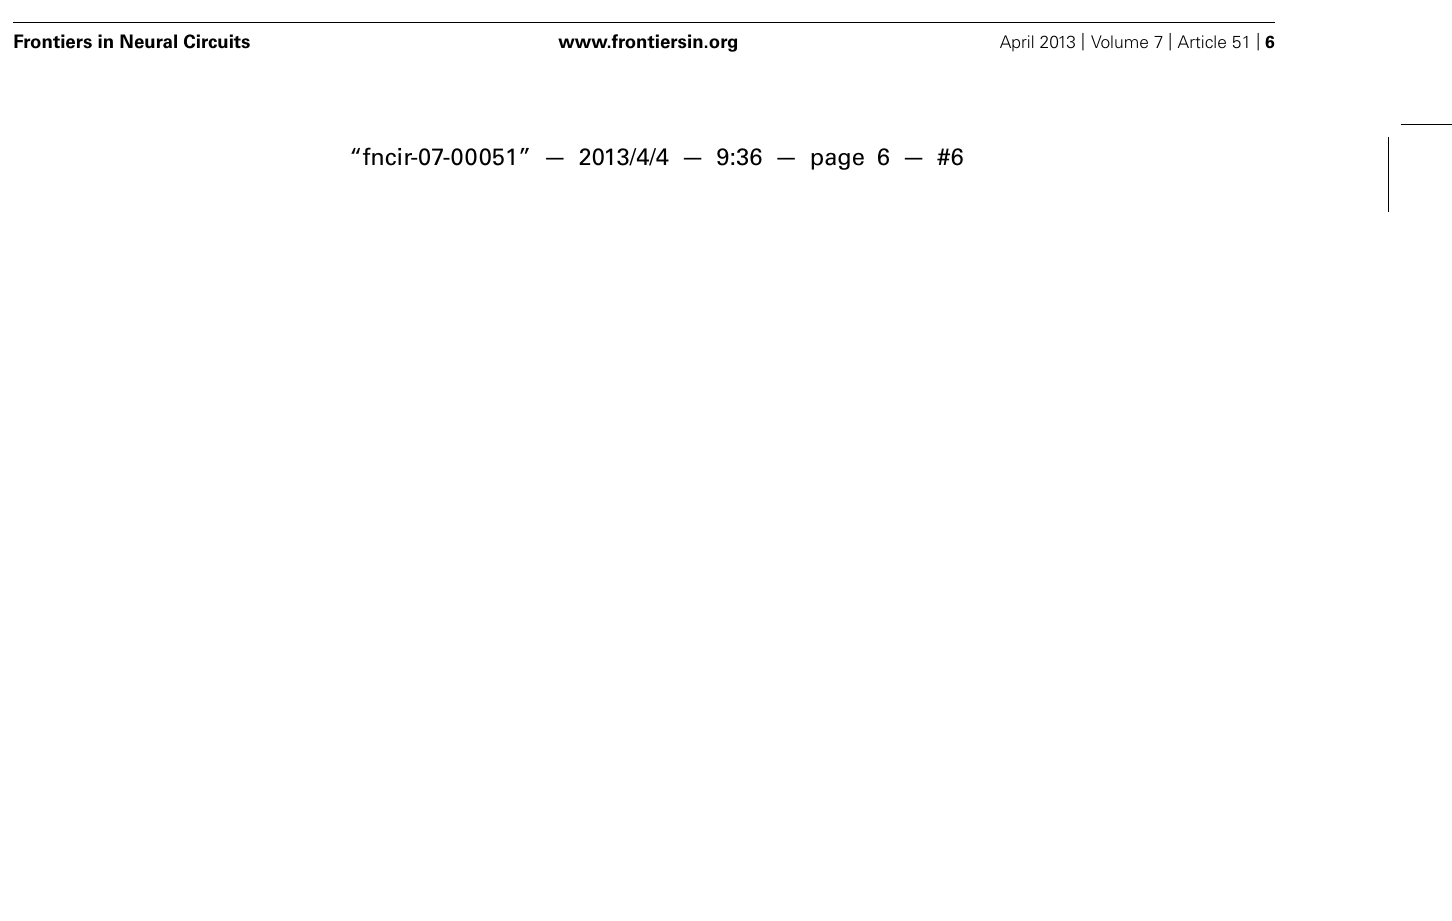
Data are reported for all single-step trials with an amplitude of 0.15 radians, and all double-step trials where each component has an amplitude of 0.15 radians. Outlying reaction times > 400 ms (6% of original data) and durations > 700 ms (7%) were removed before the mean and standard deviation were